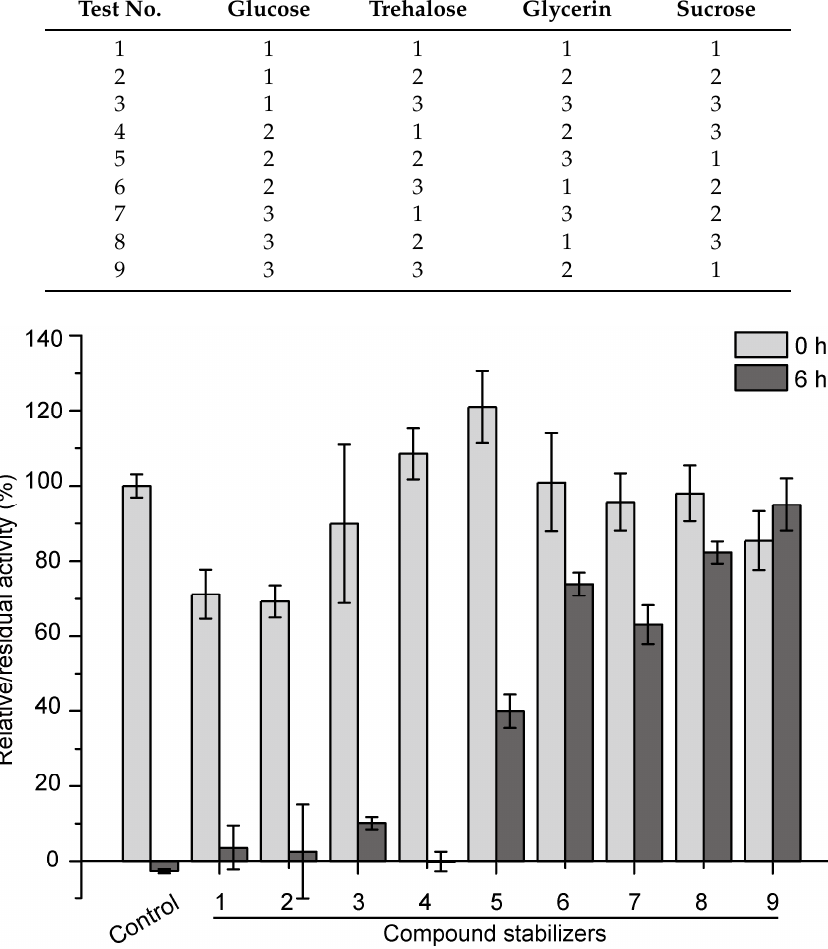
Figure 5. Effects of compound stabilizers on the activity and thermostability of pseudoalterin. The enzyme solution was mixed with each compound stabilizer and incubated at 37 °C for 6 h. The enzyme solution, mixed with 50 mM Tris-HCl (pH 9.0), served as the control. The elastase activity of the mixture before and after incubation was measured. The activity of the enzyme solution mixed with 50 mM Tris-HCl (pH 9.0) before incubation was taken as 100%. Experiments were performed in triplicate, and error bars indicate standard deviation.